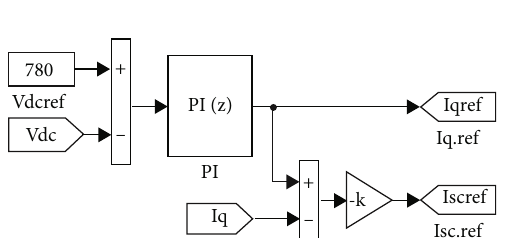
Figure 8: Rowen ’ s model of a gas turbine.